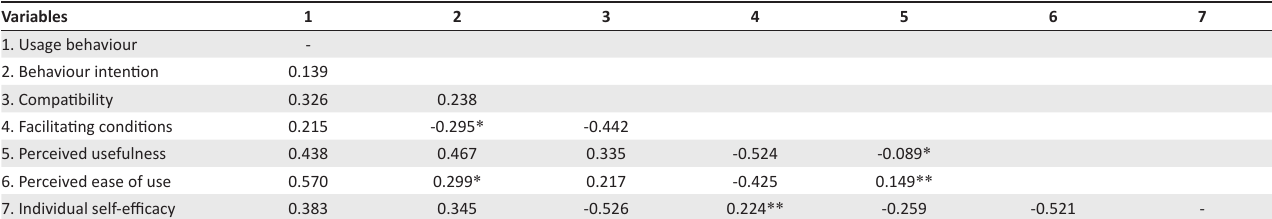
TABLE 4: Correlation